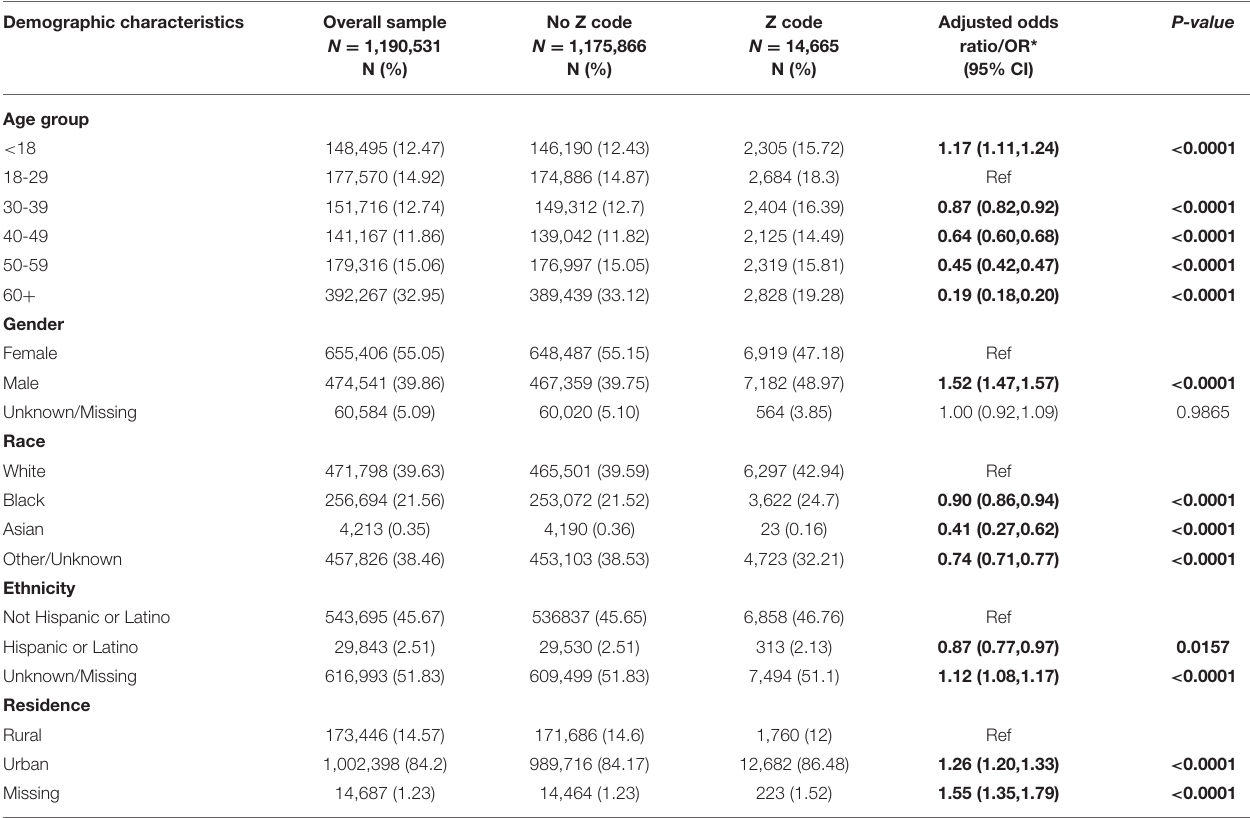
TABLE 2 | Demographic characteristics of individuals with Z codes (N = 1,190,531). Demographic